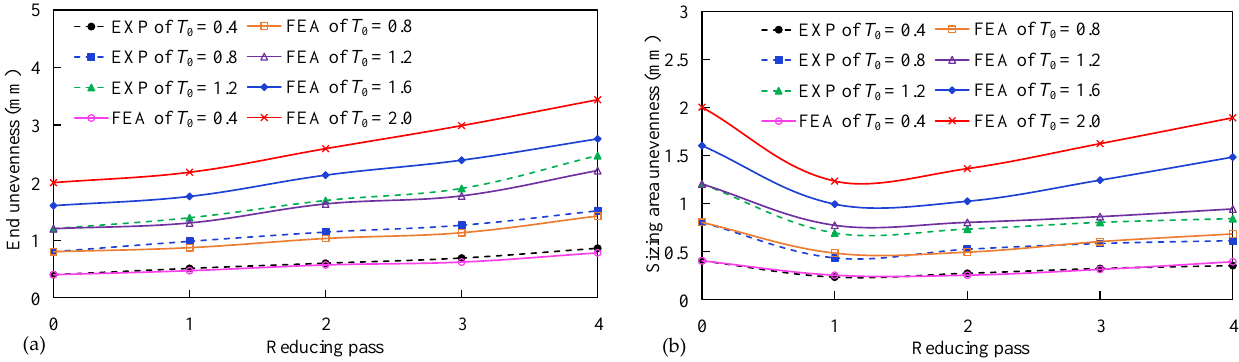
Figure 17. Unevenness of reduced tube. ( a ) The end unevenness; ( b ) the sizing area